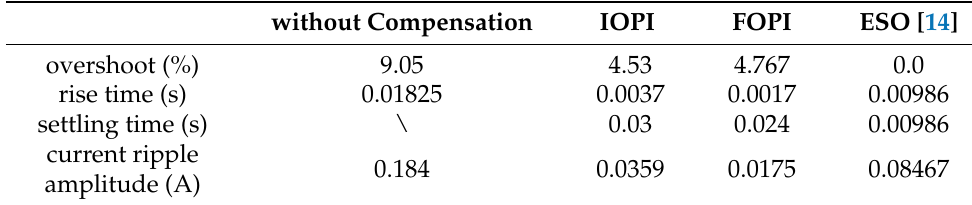
Table 5. The performance index comparison of I q step current response in the simulation.